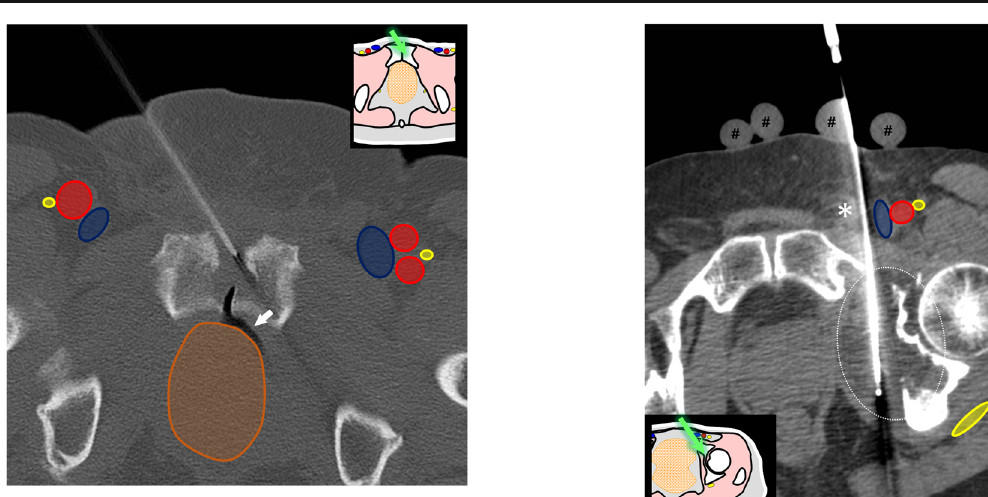
Fig. 20 A 71-year-old man with destructive pubic symphysis arthropa- thy. An anterior approach was used to perform the biopsy with a 13-G bone needle. There is gas from the pubic symphysis diffusing to the Retzius space ( white arrow )